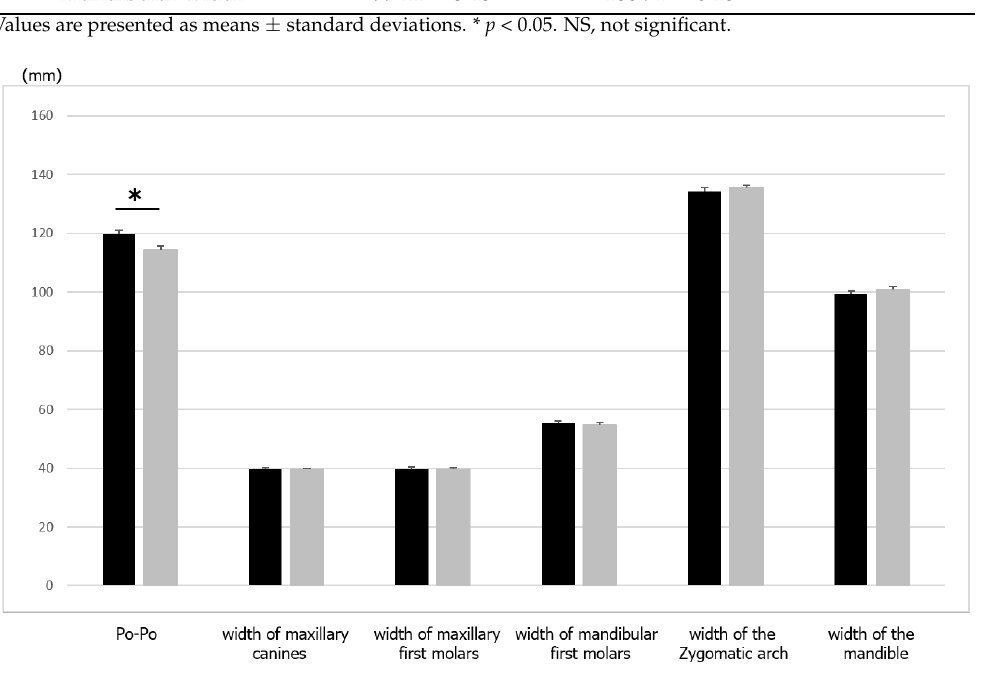
Figure 5. Comparison of the maxillary and mandibular width between samurai and commoners. Values are presented as means ± standard deviations. The asterisks represent significant differences between the groups. Black, samurai group; grey, commoners. Table 5. Comparison of the maxillary and mandibular width ratio between samurai and commoners.